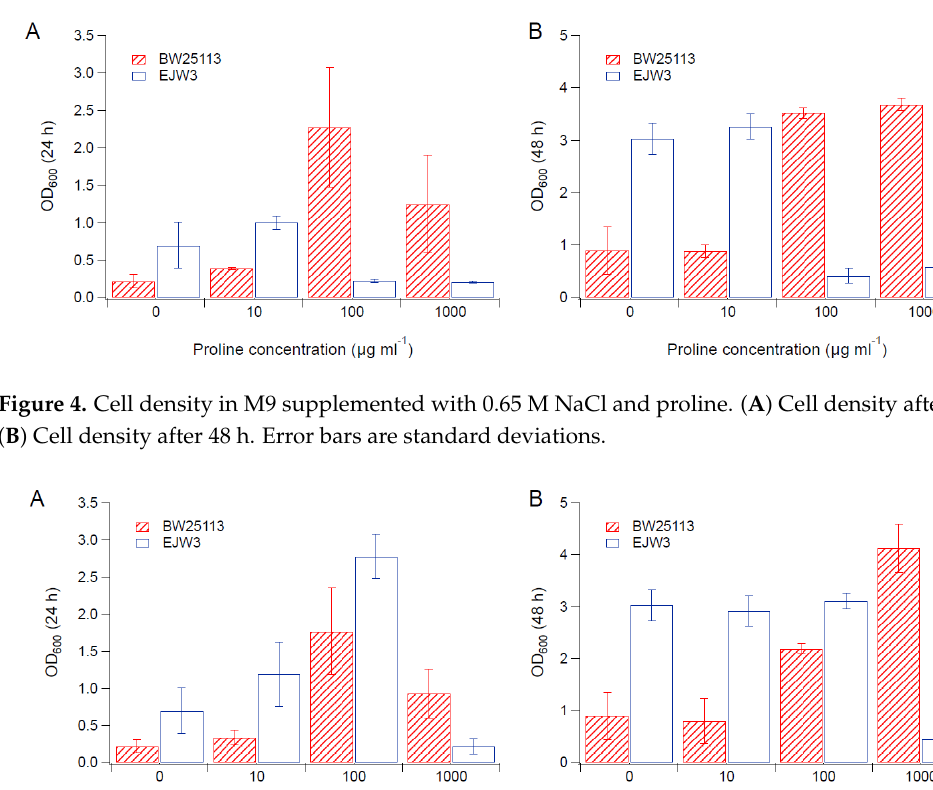
Figure 3. Cell density in M9 supplemented with 0.65 M NaCl and methionine. ( A ) Cell density after 24 h. ( B ) Cell density after 48 h. Error bars are standard deviations.